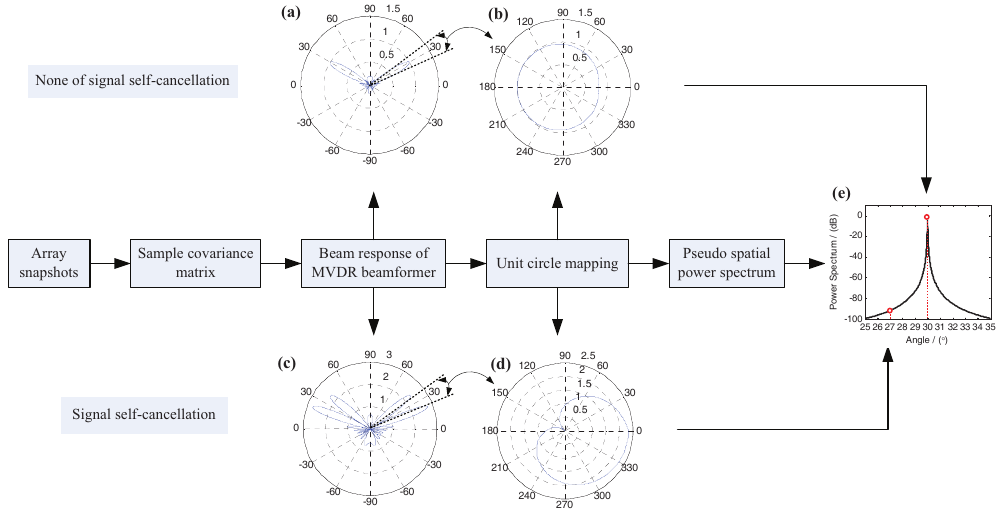
Figure 1. Implementation principle and detailed steps of the SSC-MVDR algorithm. ( a ) example of the beam response of the MVDR beamformer when there is no signal self-cancellation. ( b ) example of the unit circle mapping of the beam response curve segment on the direction interval when there is no signal self-cancellation. ( c ) example of the beam response of the MVDR beamformer when there is signal self-cancellation. ( d ) example of the unit circle mapping of the beam response curve segment on the direction interval when there is signal self-cancellation. ( e ) example of the pseudo spatial power